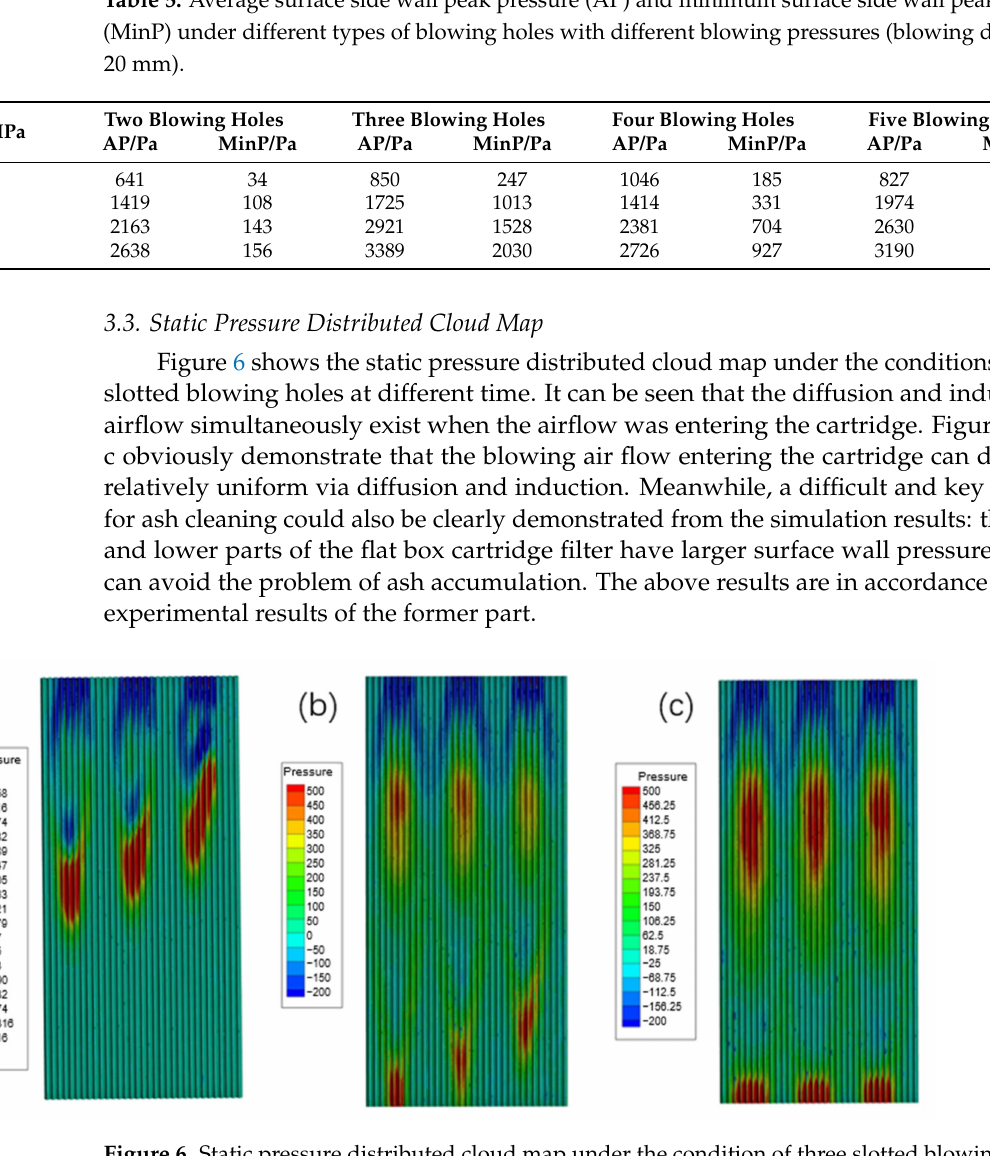
Figure 6. Static pressure distributed cloud map under the condition of three slotted blowing holes at ( a ) 0.01 s, ( b ) 0.02 s, and ( c ) 0.03 s.